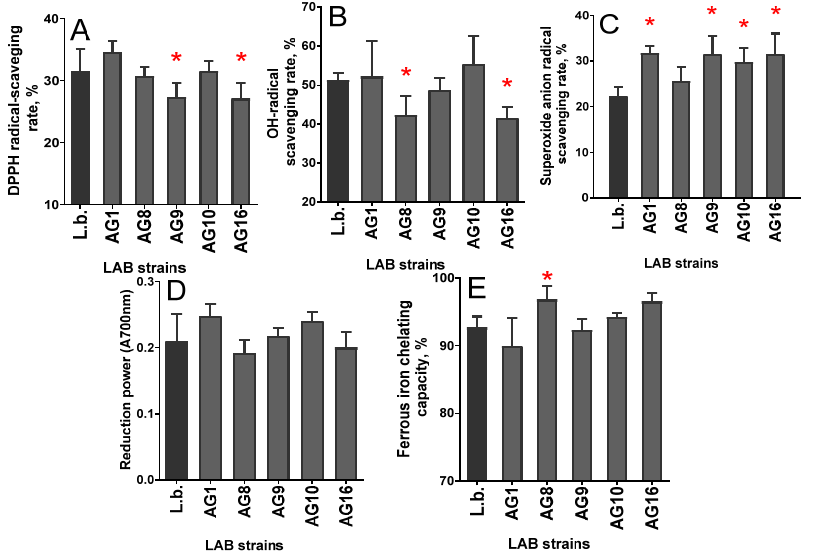
Figure 2. Antioxidant and chelating properties of a protein-free extract (pre-neutralized to pH = 7) isolated from skim milk fermented with different strains of LAB (L. b.— L. bulgaricus , AG1— L. plantarum AG1, AG8— L. fermentum AG8, AG9— L. plantarum AG9, AG10— L. plantarum AG10, AG16— L. rhamnosus AG16). ( A ) DPPH scavenging activity; ( B ) OH scavenging activity; ( C ) O2 − scavenging rate; ( D ) Ferric Reducing Antioxidant Power Assay (FRAP); ( E ) Fe-Chelating Activity. Asterisks indicate statistically significant differences with L. bulgaricus according to non ‐ parametric one ‐ way analysis of variance (Kruskal–Wallis) test, p < 0 . 05.